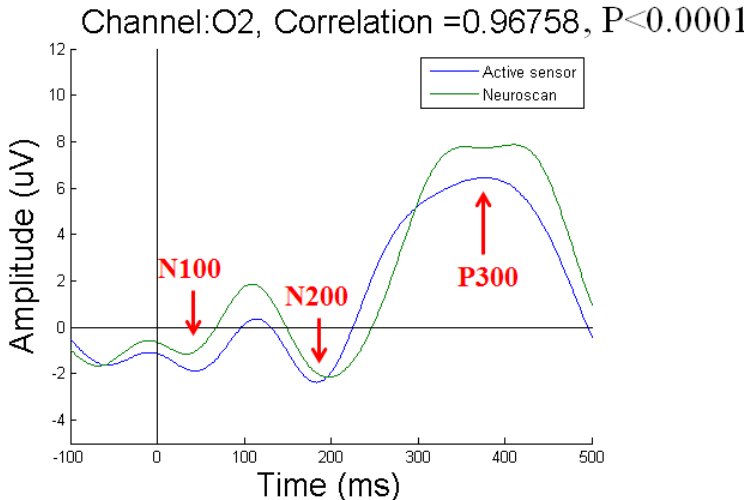
Figure 12. Event-related potential (ERP) results for subject 1 at O2.